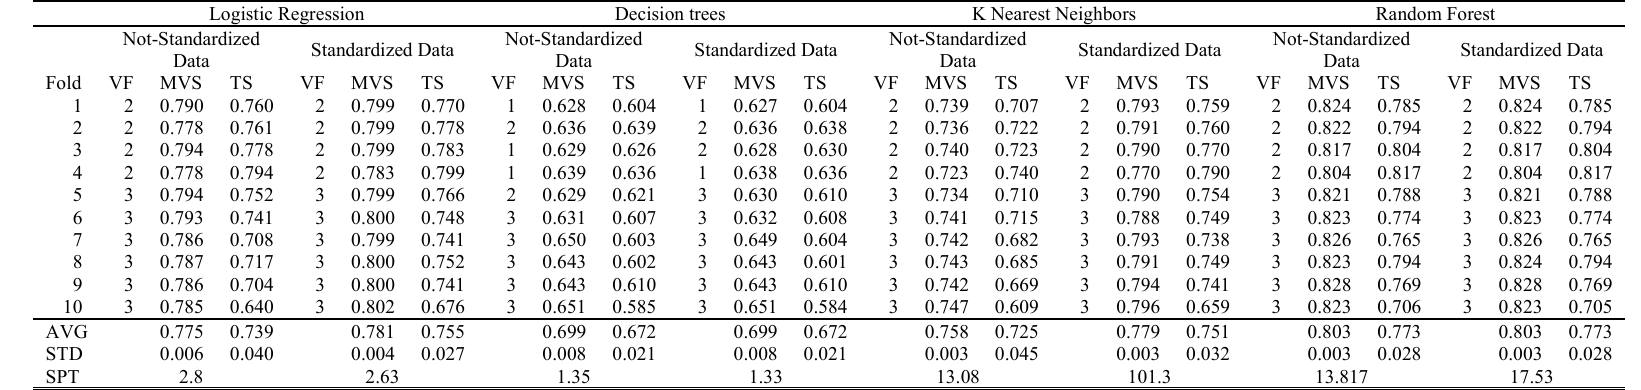
TABLE 5 E VALUATION R ESULT OF T EN -F OLD T HREE -W AY S PLIT P